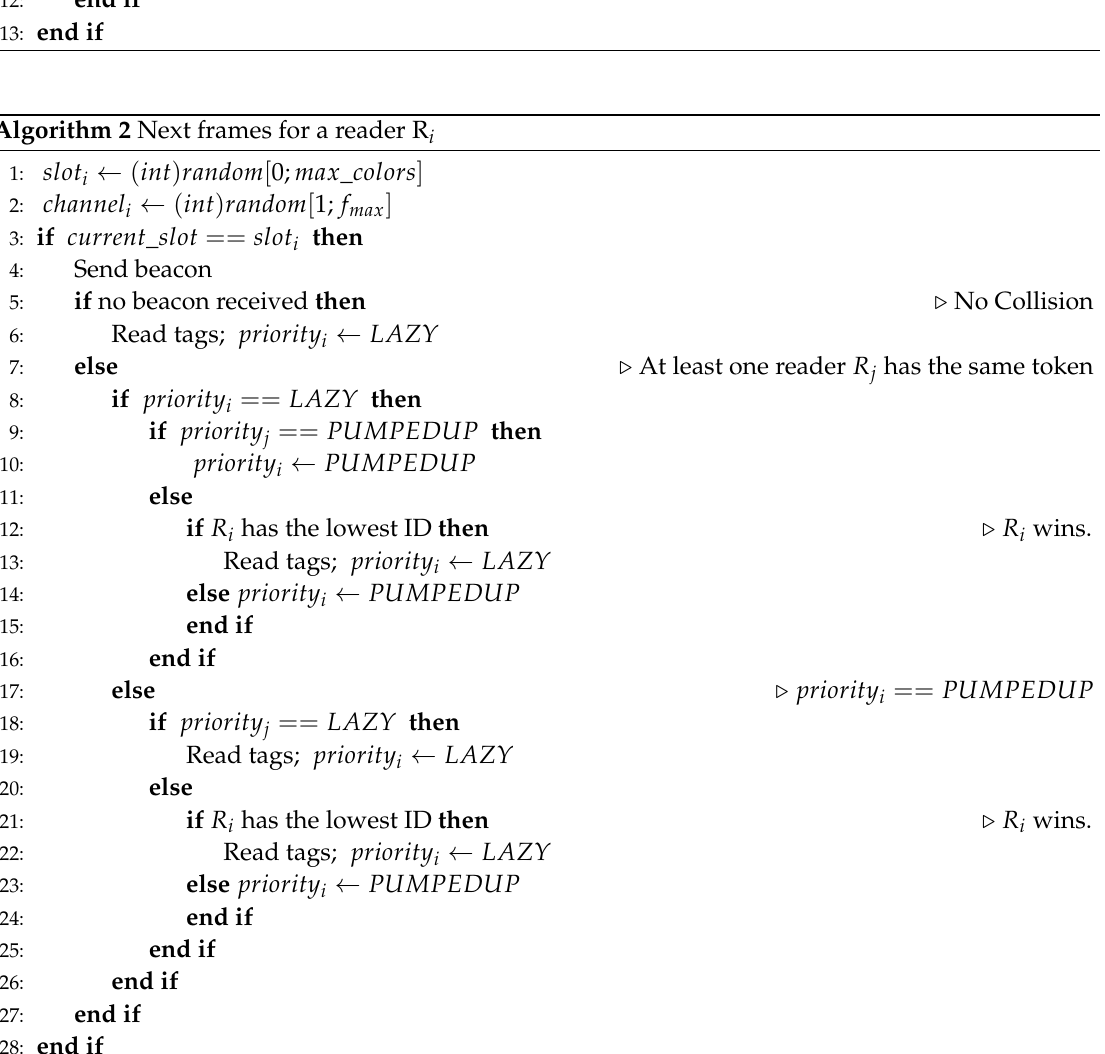
Algorithm 2 Next frames for a reader R